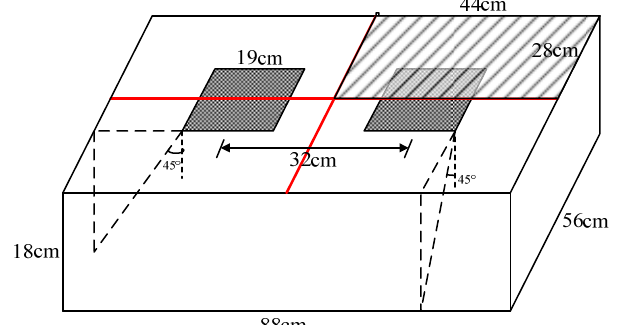
Figure 2. Load area and model dimensions.